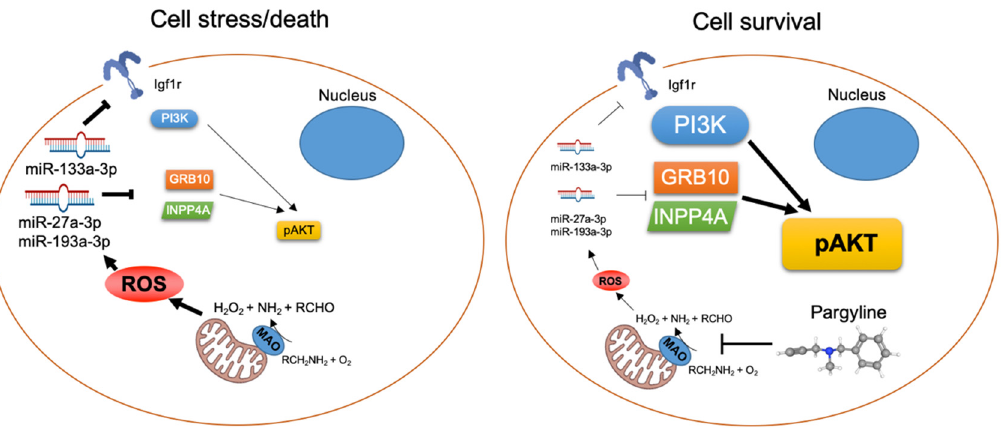
Figure 8. Graphical abstract of the main findings of this study indicating MAO-dependent post- transcriptional regulation of Igf1r , Grb10 and Inpp4a via miR-133a-3p, -27a-3p and -193a-3p, which in turn regulate pro-survival signaling through AKT activation in diabetic hearts.